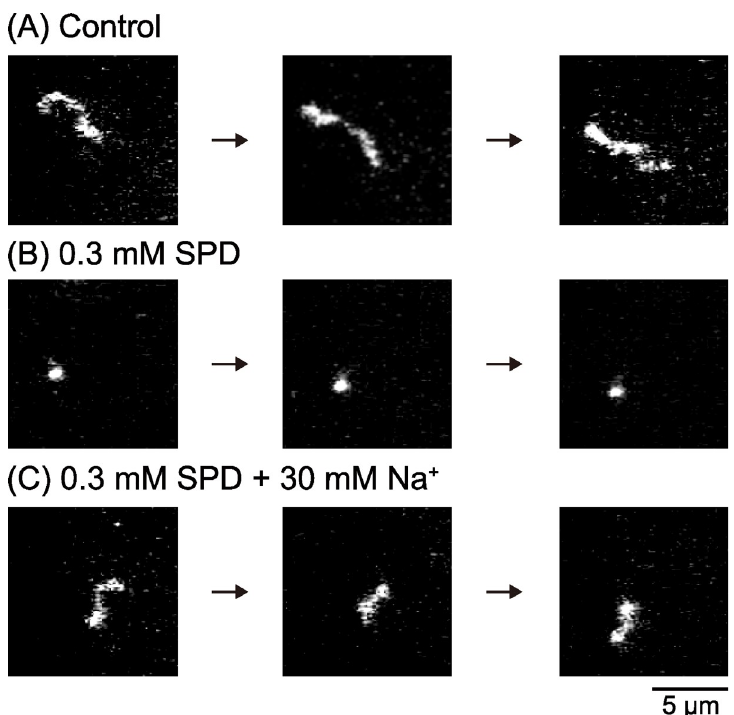
Fig 2. Examples of FM images of a single T4 DNA molecule undergoing Brownian motion in solution. (A) In the absence of any condensation agent such as SPD, Na + or K + . (B) In the presence of 0.3 mM SPD. (C) In the presence of 0.3 mM SPD and 30 mM Δ C Na . The total observation time for (A)–(C) is 3